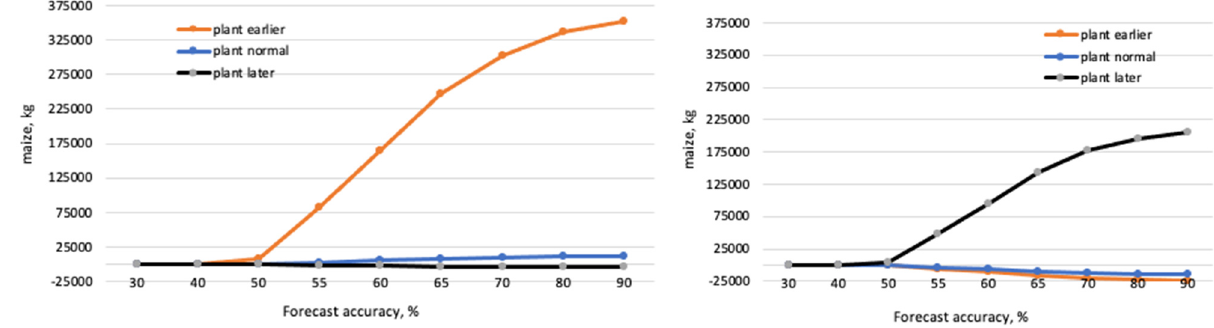
Figure 11. Productivity changes in the Kebele due to forecast accuracy.